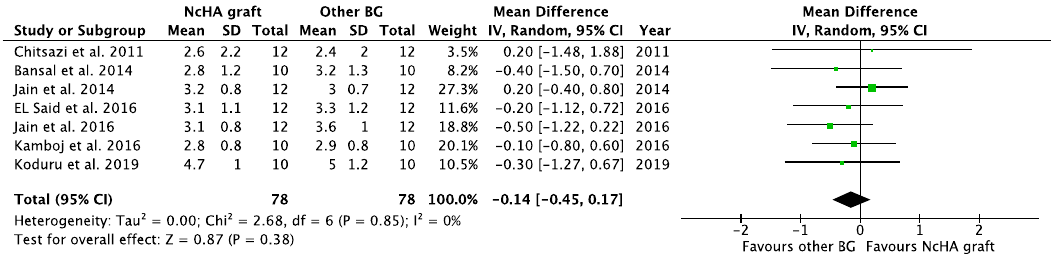
Figure 3. Forest plots demonstrating the comparison of NcHA graft versus other BG (CAL gain). NcHA: nanohydroxyap- atite; BGs: bone graft; IV: inverse variance; SD: standard deviation; Total: number of patients; 95% CI: confidence interval.